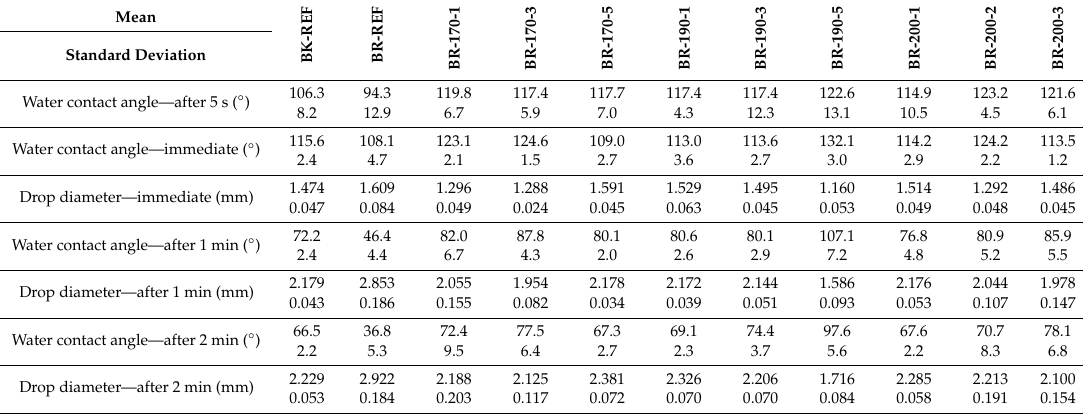
Table 4. The basic statistical analyses of the wetting